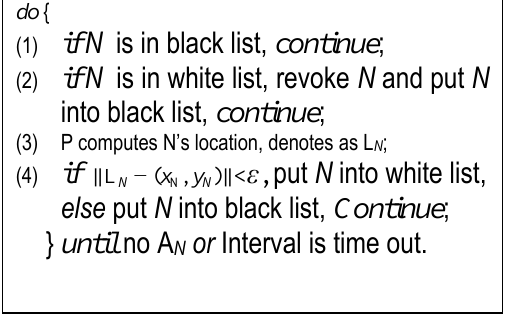
Figure 2. Detection algorithm of node